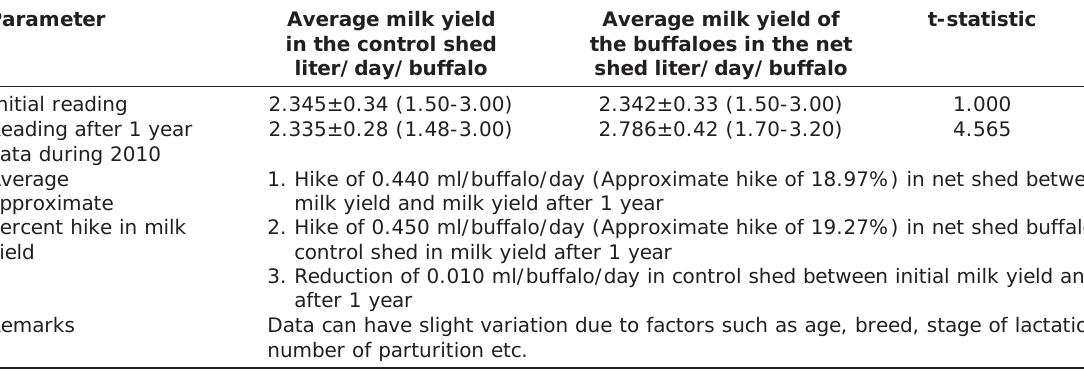
Table-2: Average hike in milk yield in Marathwadi buffaloes.